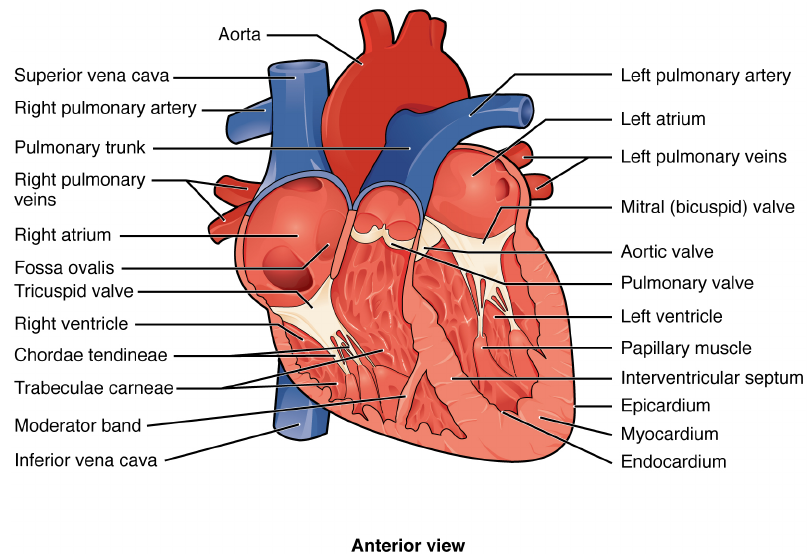
Figure 1. An anterior view of the heart [courses.lumenlearning.com/contemporaryhealthissues].